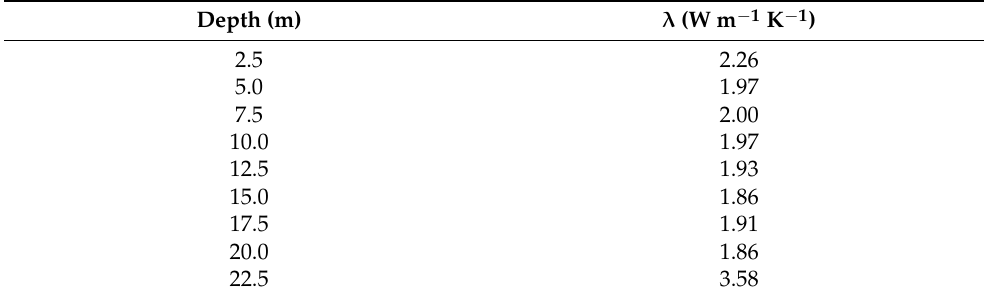
Table 1. Thermal conductivity deduced from the recovery period for the constant-heat-injection TRT.